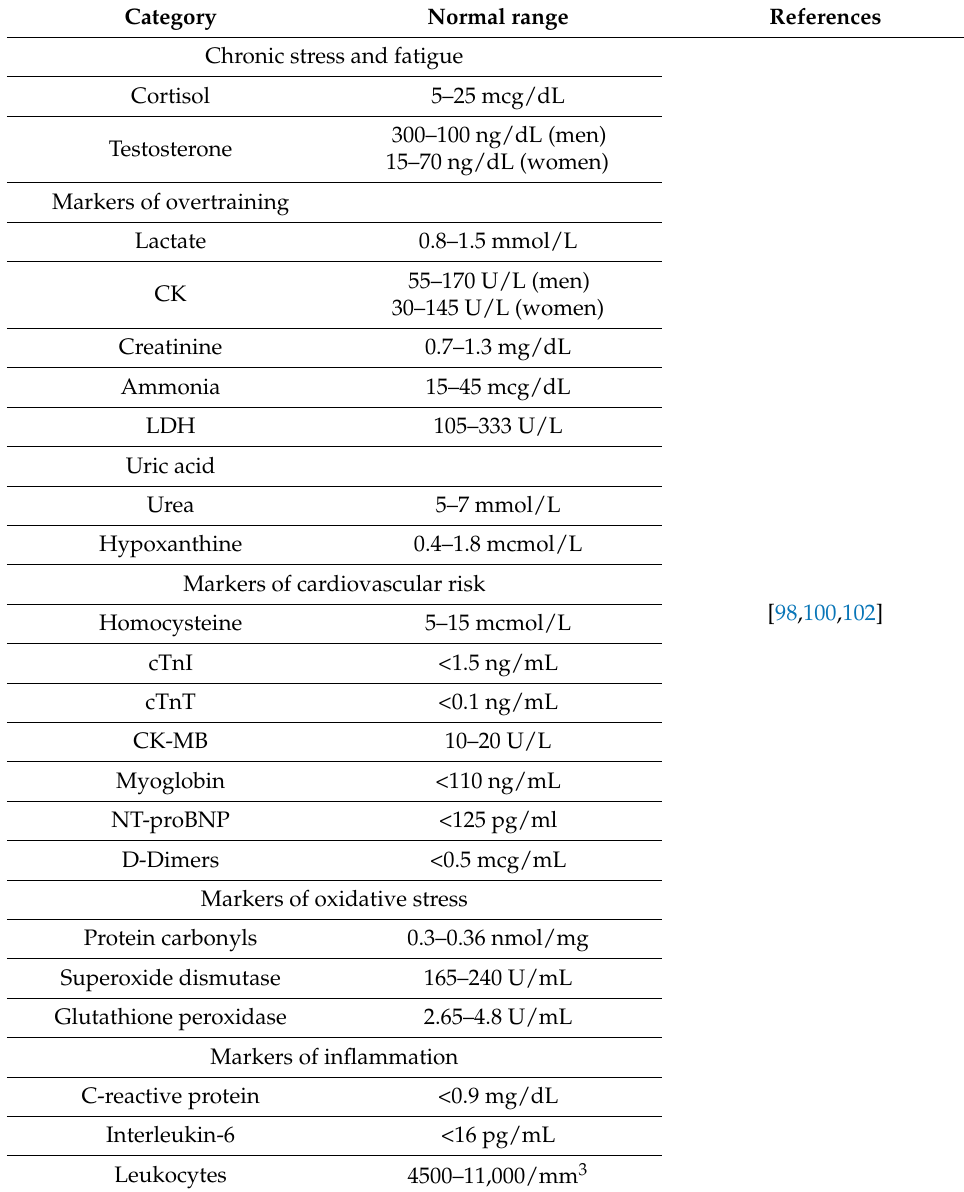
Table 3. Biomarkers used in physical activity assessment (Palacios et al.